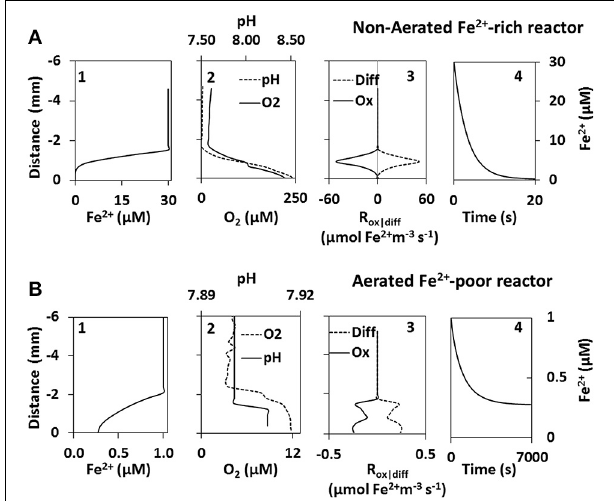
FIGURE 4 | Fe 2 + model results of the non-aerated Fe 2 + -rich (A) and aerated Fe 2 + -poor (B) reactors. Steady state Fe 2 + profiles above cyanobacteria biofilms (graph 1) were calculated using microprofiles of O 2 and pH measured in-situ (graph 2). Steady state was achieved once Fe 2 + consumption by abiotic oxidation (Ox) was equal to Fe 2 + supplied by diffusion (Diff) (graph 3). The change in Fe 2 + concentration at the biofilm surface is shown as a function of time (graph